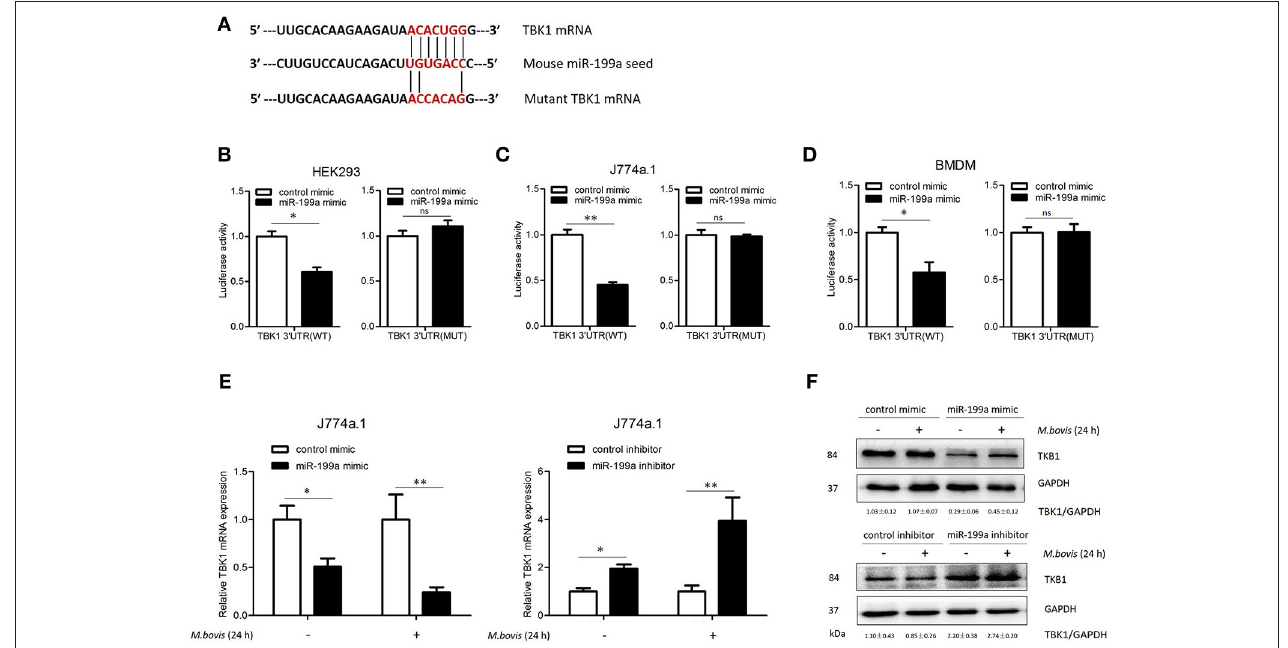
FIGURE 2 | miR-199a inhibits the expression of TANK-binding kinase 1 (TBK1) by targeted TBK1 3 ′ UTR. (A) Bioinformatics software identification of the miR-199a target gene HEK293 cells (B) , J774a.1 cells (C), and mouse bone marrow monocyte-derived macrophages (BMDMs) (D) were cotransfected with pmirGLO vector carrying TBK1 WT or mutant constructs (MUT), along with a miR-199a mimic, and a luciferase assay was performed. (E) J774a.1 cells were treated with miR-199a mimic or inhibitor and then either uninfected or infected with Mycobacterium bovis ( M. bovis ) at a MOI of 10 for 24h. TBK1 expression was determined by Quantitative Real-Time PCR. (F) Western blots of TBK1 protein expression levels. Quantitative analysis of TBK1 normalized to GAPDH is shown below each blot. Data is presented as mean ± SD in three independent experiments (* P < 0.05; ** P <